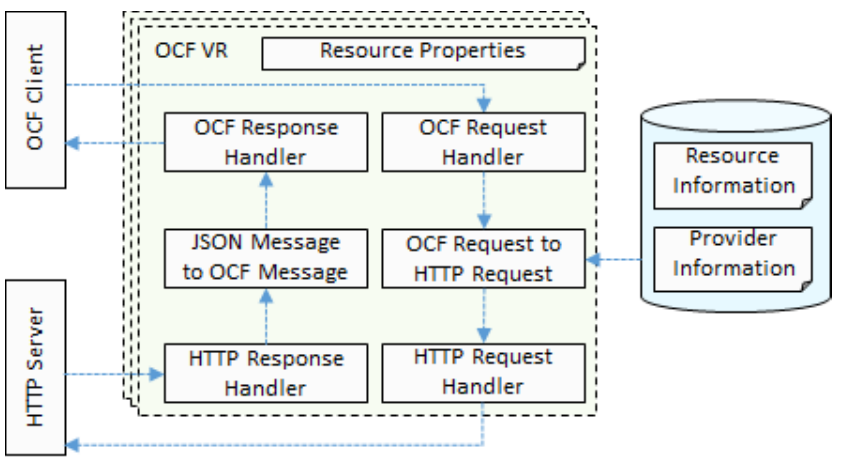
Figure 5. Message translating mechanism for OCF to HTTP.